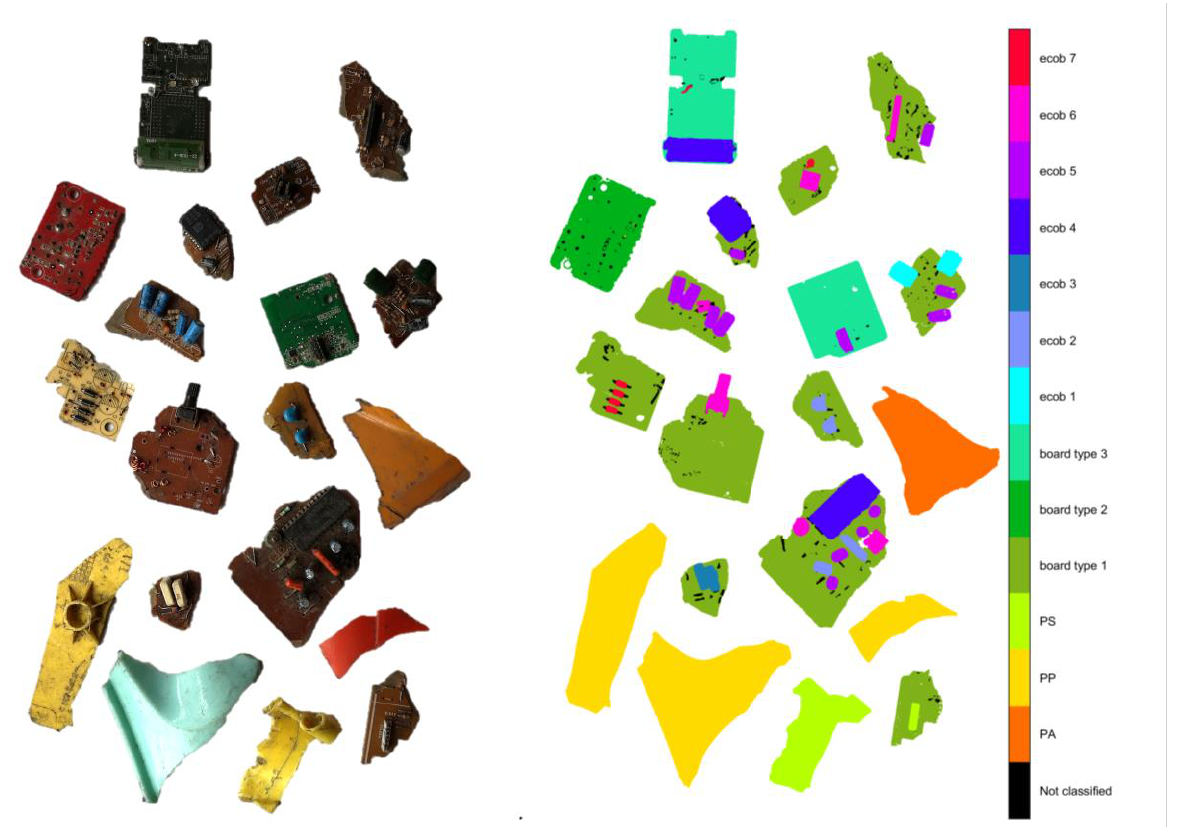
Figure 14. Result of classification for PCBs using 3D features (after step 3). Classification of four different types of compo- nents on board (ecob 4, ecob 5, ecob 6 and ecob 7).